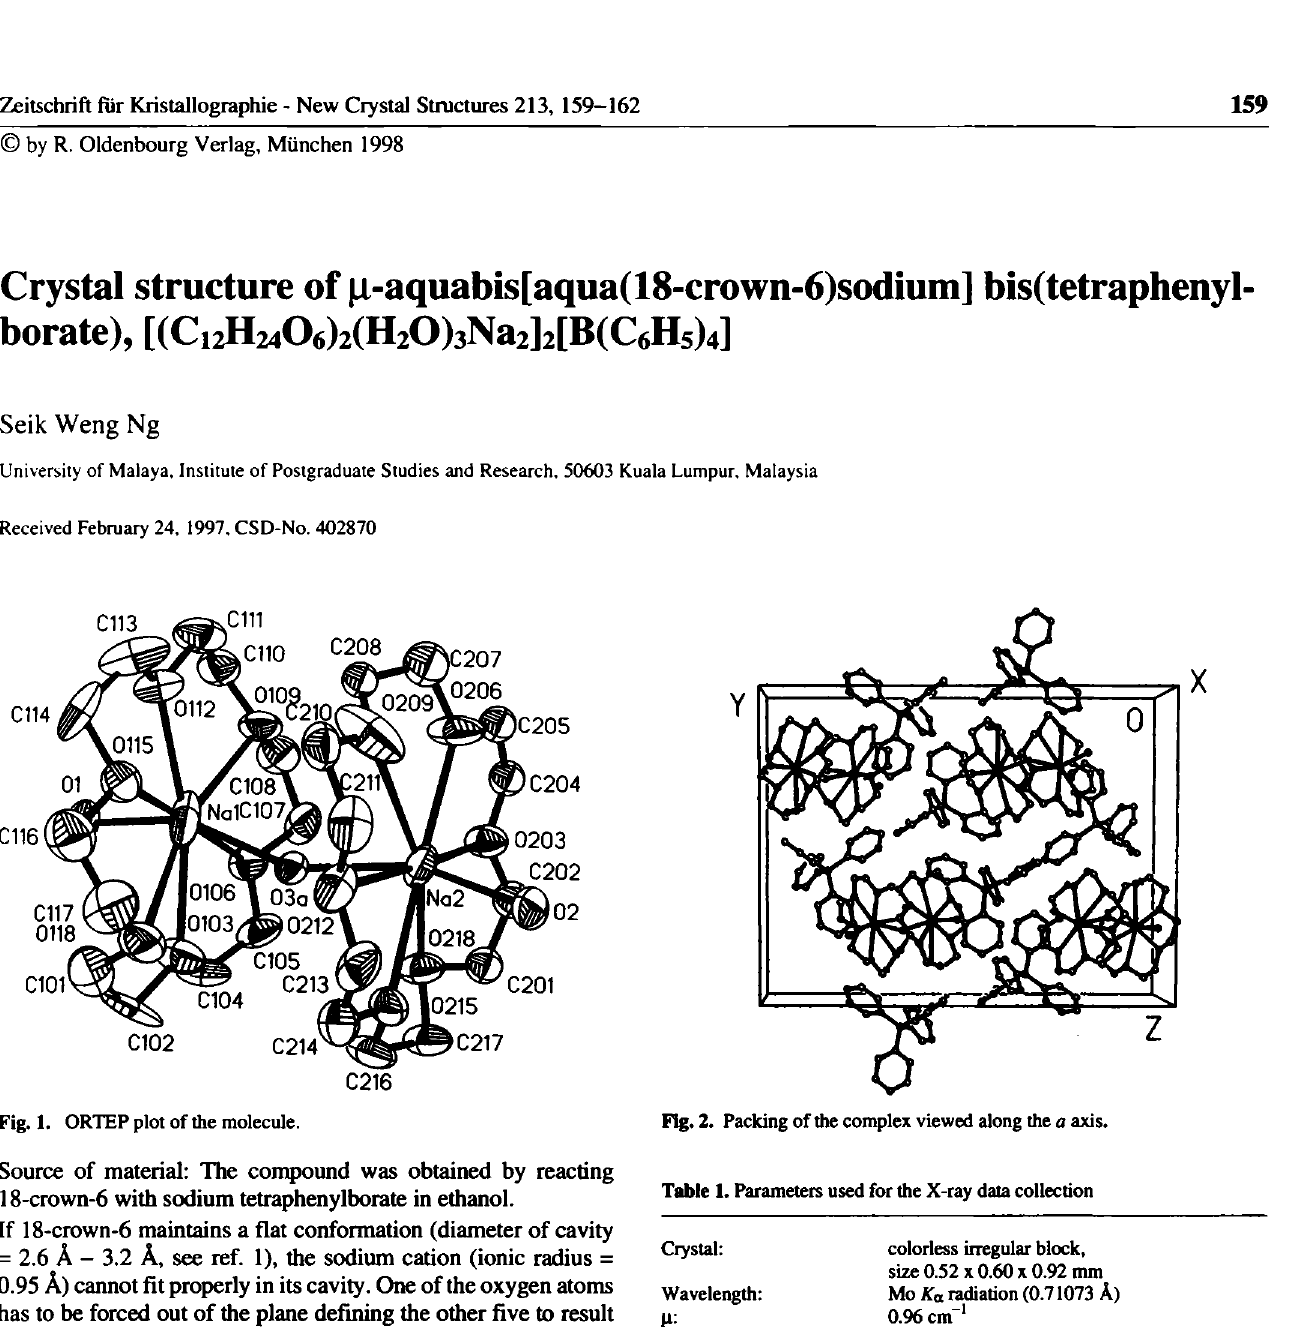
Table 1. Parameters used for the X-ray data collection